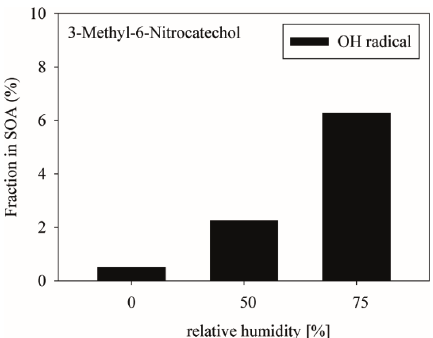
Figure 7. Fraction of 3-methyl-6-nitrocatechol from the oxidation of m -cresol with OH. Please note that other compounds from the ASOA standard (Hoffmann et al., 2007) were not identified, and due to the low SOA yield from NO 3 -radical reaction the concentration might be below the detection